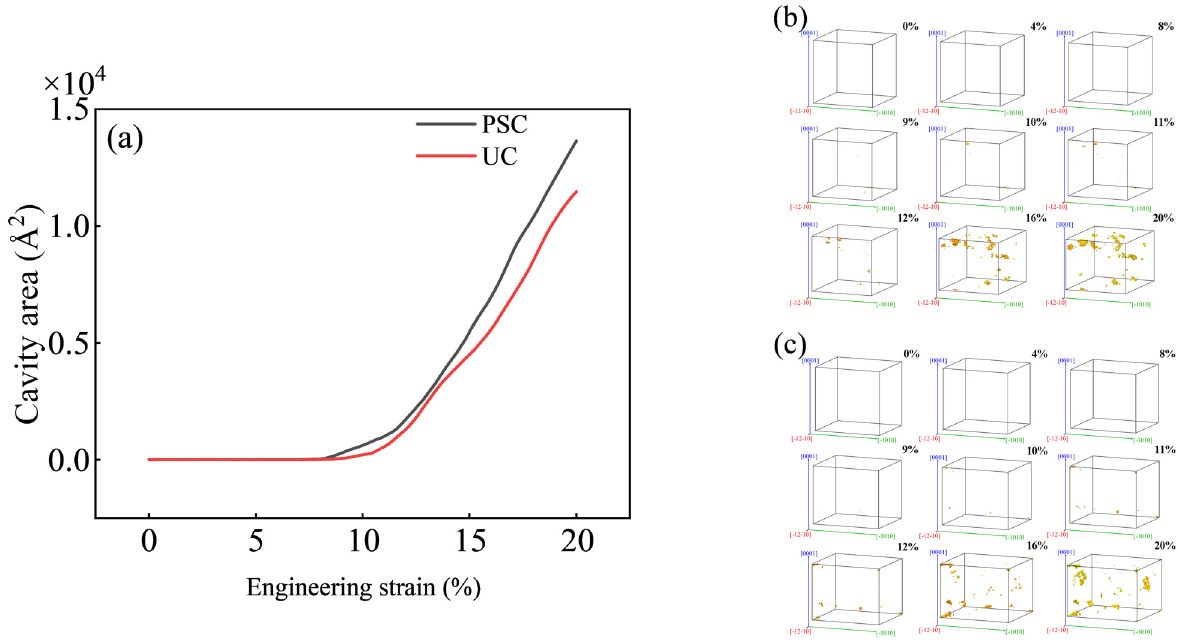
Figure 5: Cavity evolution: ( a ) cavity area curve, ( b ) cavity evolution under PSC, and ( c ) cavity evolution under UC.